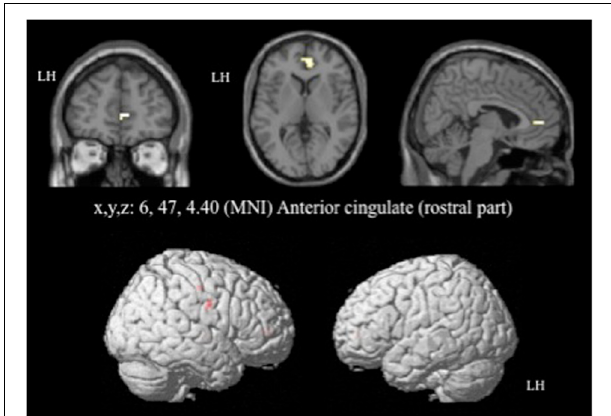
FIGURE 6 | Brain activation during the emotional Stroop task with negative faces (contrast [I-C]) in the between group comparison (Control vs. drug-off patients). p < 0 . 001, k > 5, n healthy = 12, n patients = 10, uncorrected. I; incongruent; C; congruent; LH, left hemisphere; x, y, z: mediolateral, rostrocaudal, and dorsoventral; MNI, Montreal Neurological Institute.